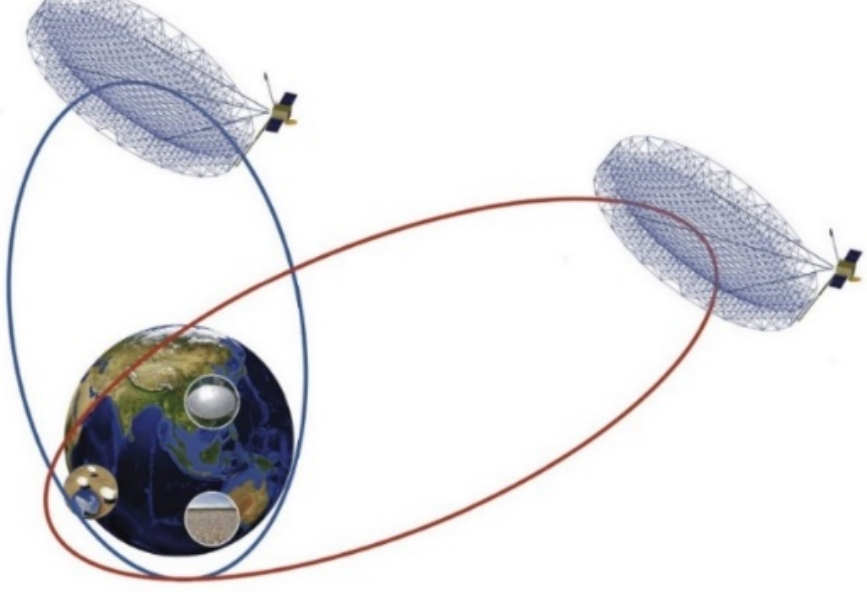
Figure 1. Sketch of